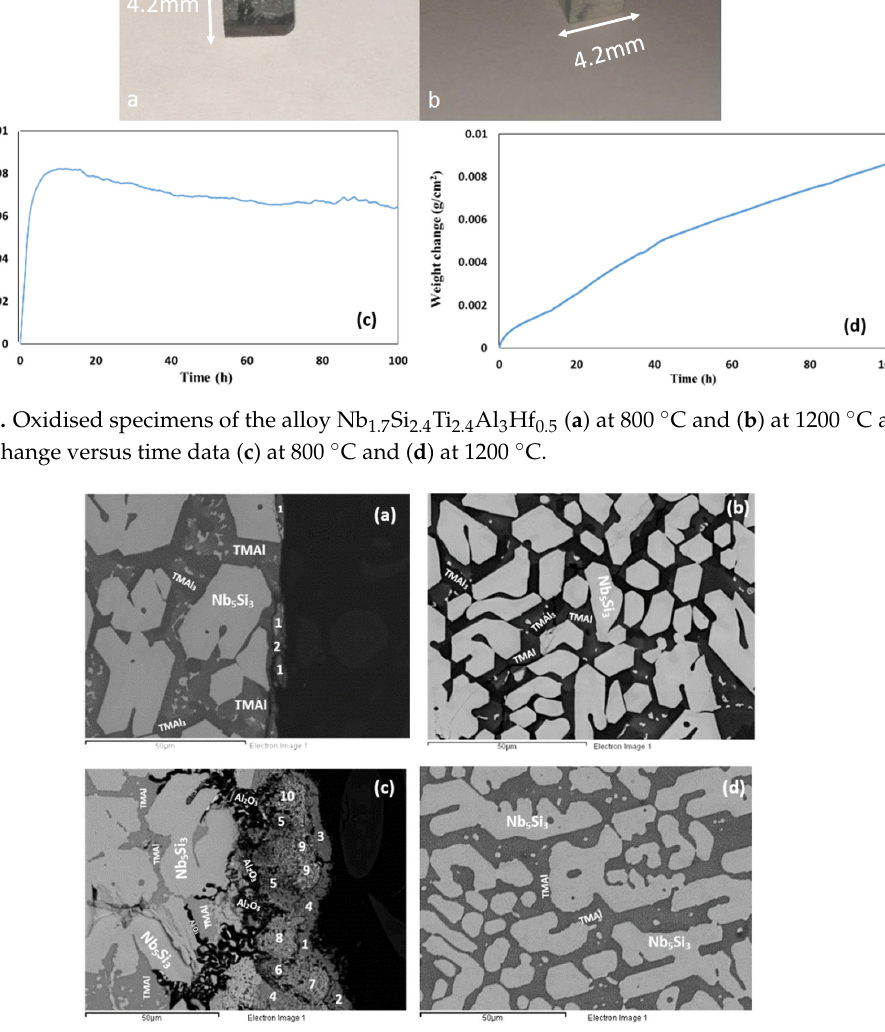
Figure 9. SEM backscatter electron images of the microstructure of the alloy Nb 1.7 Si 2.4 Ti 2.4 Al 3 Hf 0.5 after isothermal oxidation ( a , b ) at 800 °C; ( c , d ) at 1200 °C. ( a , c ) scale and substrate below scale; ( b , d ) bulk. In ( a ) 1 is Si rich oxide with Al,Nb,Ti, and 2 is Al rich oxide with Nb,Si,Ti. In ( c ) 1, 2, 3 indicate Ti rich mixed oxides, 4, 5 indicate Al and Ti rich mixed oxides, 6, 7, 8, 9, 10 indicate Si and Nb rich mixed oxides.